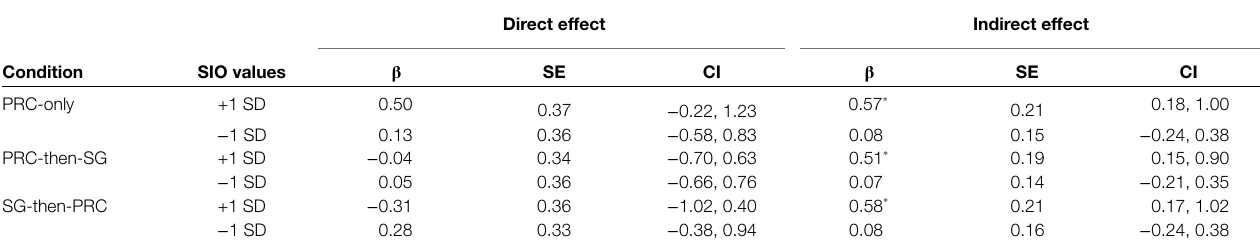
TABLE 2 | Direct and indirect effects via empathy of PRC embodiment on change in self-other overlap, conditional on social identity orientation (SIO). Values are based on z-scored empathy, SIO, and change in self-other overlap.